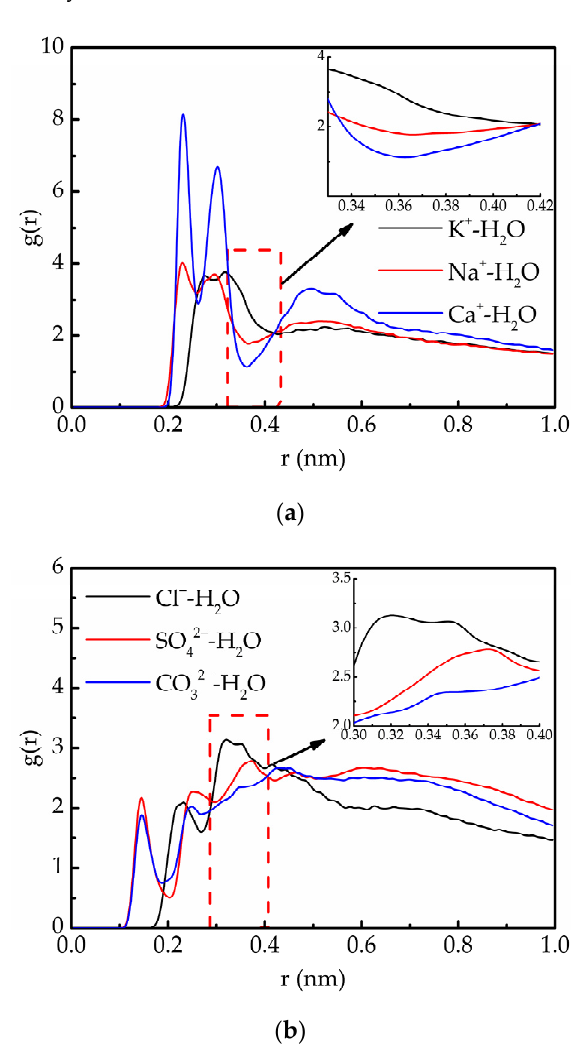
Figure 9 . Radial distribution functions (RDFs) between solute ions and H 2 O molecule: ( a ) RDFs between Na + , K + , Ca 2+ and H 2 O; ( b ) RDFs between Cl − , CO 32 − , SO 42 − and H 2 O.